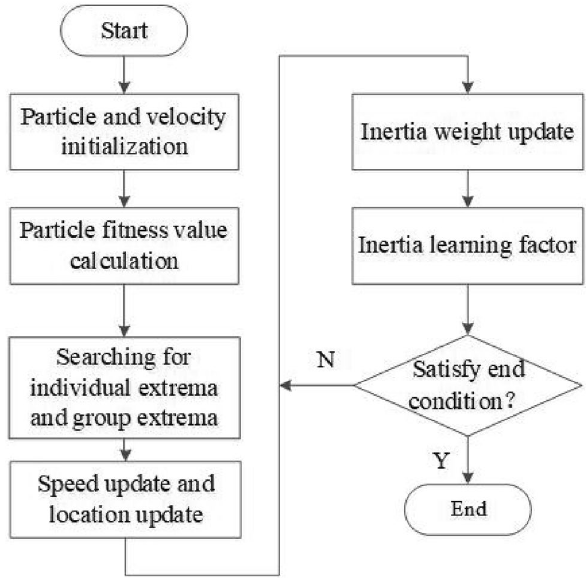
Figure 5. The flowchart of the MKL-SVM-IPSO